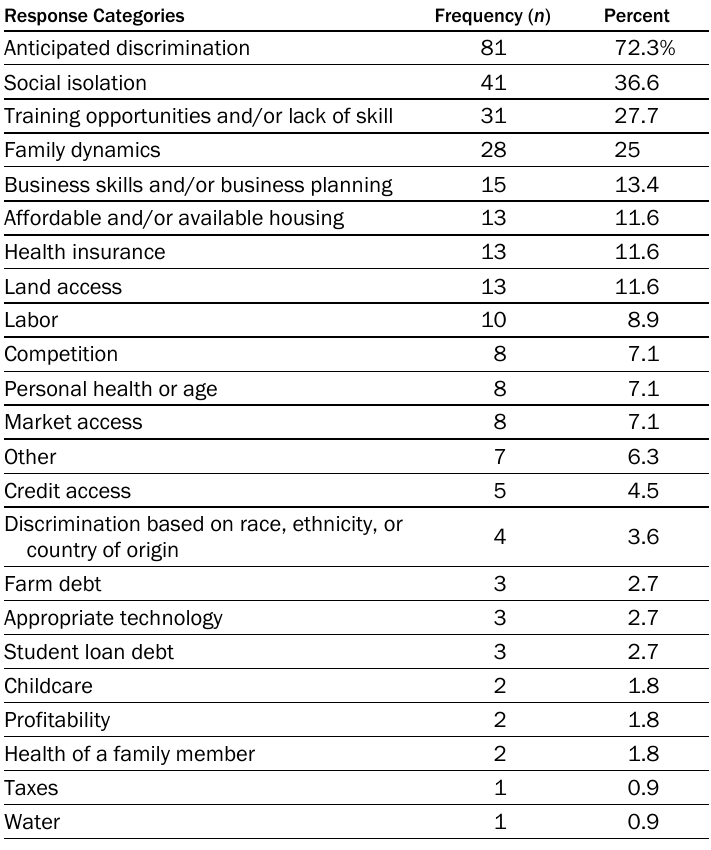
Table 2. Challenges Encountered Due to